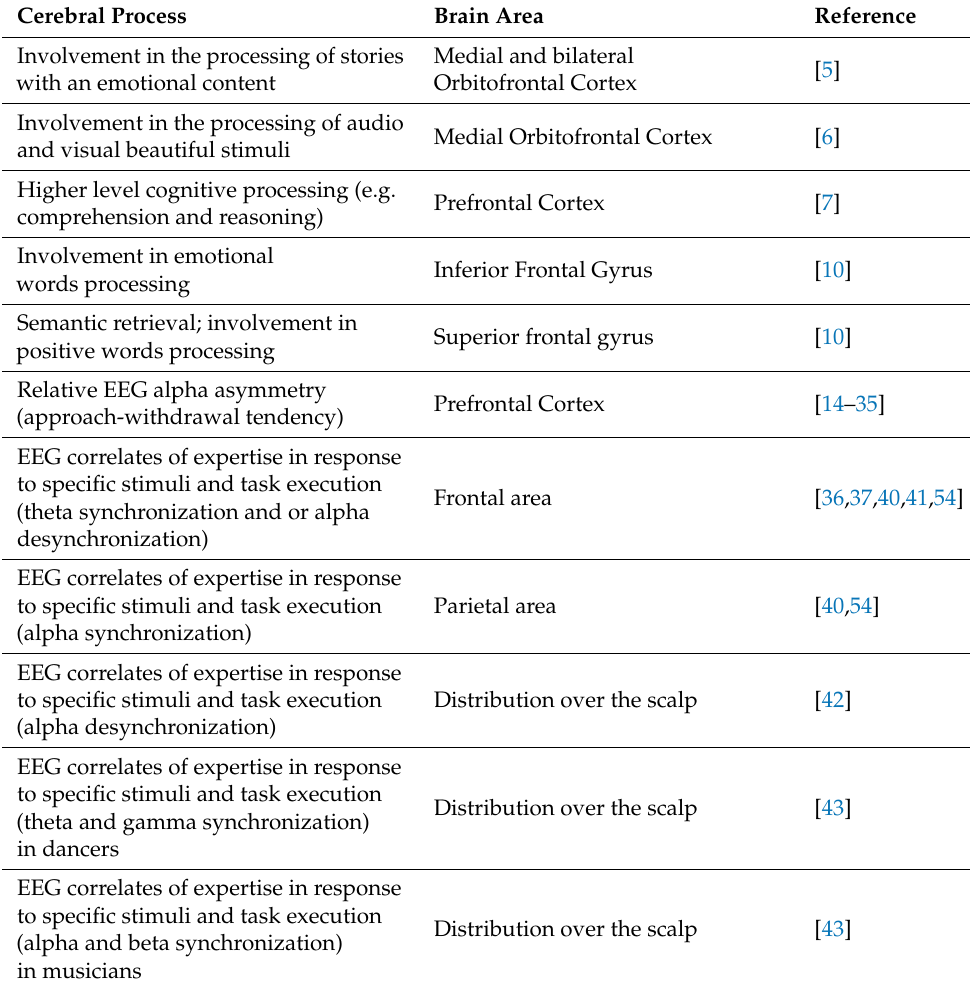
Table 1. The table summarizes mentioned cerebral processes and relative brain areas (see the main text for further